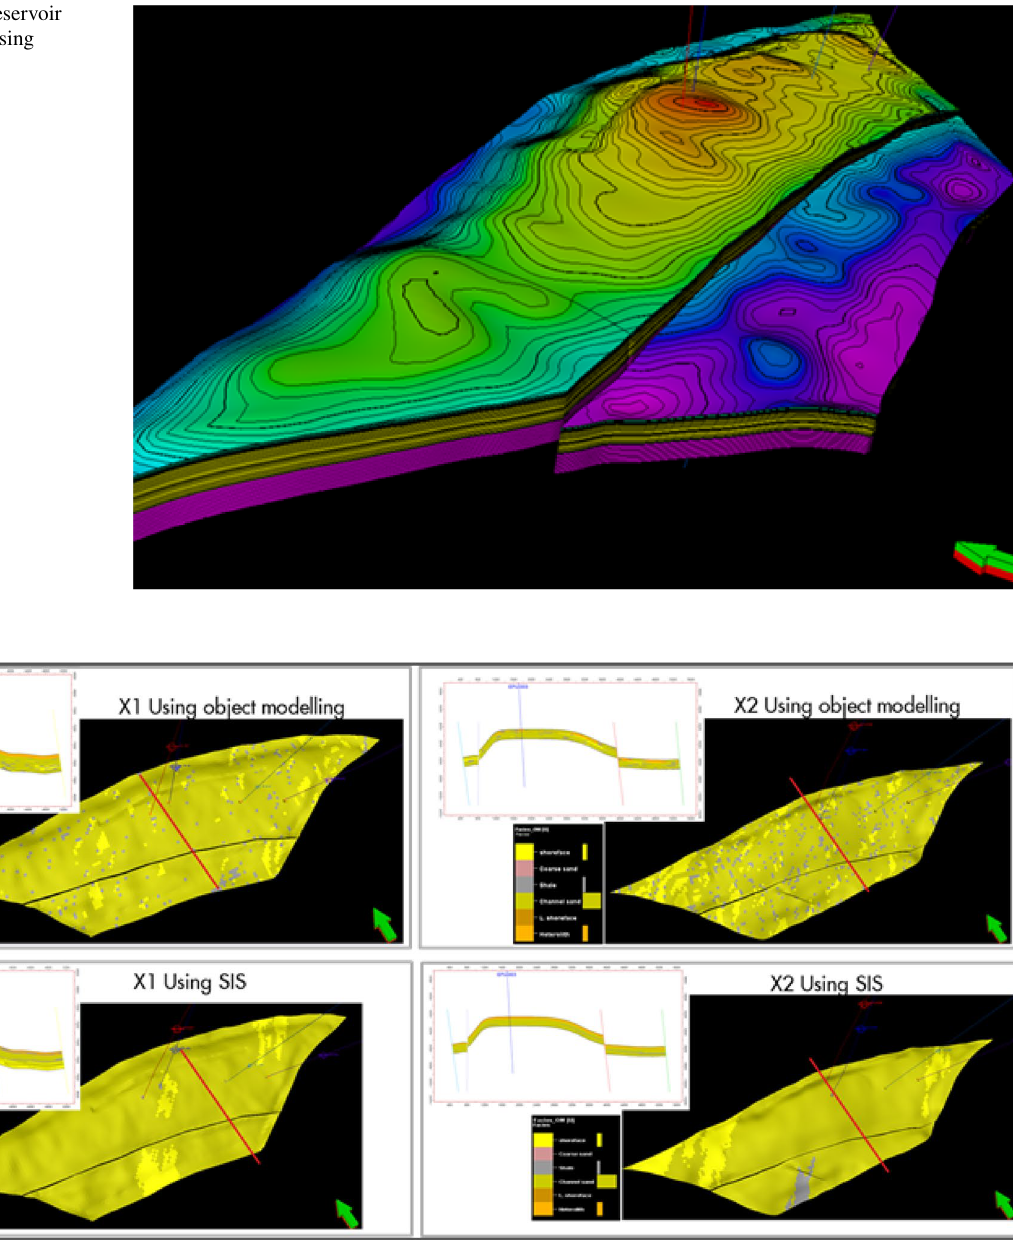
Fig. 15 3D grid from reservoir structural model after using corner point gridding